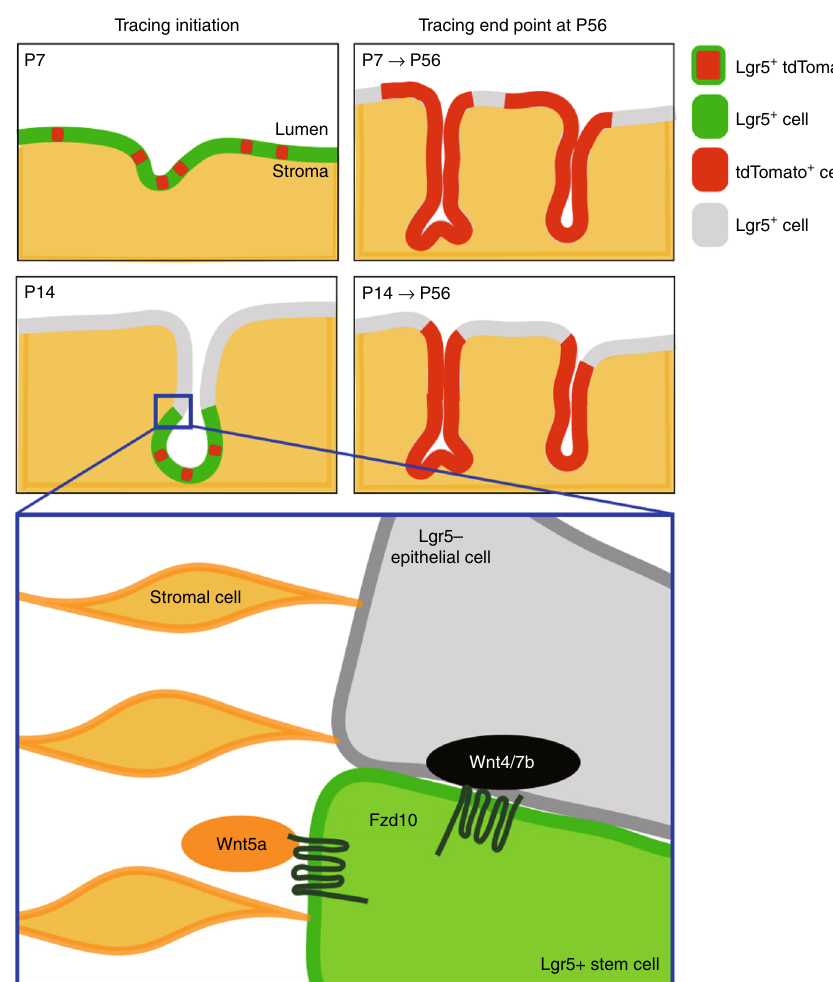
Fig. 9 Summary cartoon depicting the dynamic expression pattern and function of Wnt-regulated Lgr5 + cells in the immature uterus. At P7, Lgr5 + cells are uniformly distributed throughout the endometrium and contribute to the development of both the LE and GE. After P14, Lgr5 + cells become restricted to the tips of developing glands and exclusively contribute to the development of GE. Wnt signaling is instrumental in regulating the activity of the Lgr5 + stem/progenitor cells at P14, likely mediated by interaction of Fzd10 with Wnt ligands supplied by both epithelial and stromal populations. Organoid culture . FACS-sorted single endometrial cells were seeded in growth factor-reduced Matrigel (Corning, 356231) and cultured in Advanced DMEM/F-12 media supplemented with 10mM HEPES, 2mM Glutamax, 1x N2, 1x B27 (all Invitrogen), N -acetyl-cysteine (Sigma, A9165), Primocin (Invivogen, ant-pm1), noids were harvested for analysis. DT was added at a concentration of 0.25 ng/ μ l to 50ng/ml EGF (Invitrogen, PHG0311), 100 ng/ml FGF10 (Peprotech, 100-18B), the culture medium to induce Lgr5 + cell ablation at the indicated time point. 100 ng/ml Noggin (Peprotech, 250-38-50), 100ng/ml Wnt3a (Millipore, GF-160), NATURE COMMUNICATIONS| (2019) 10:5378